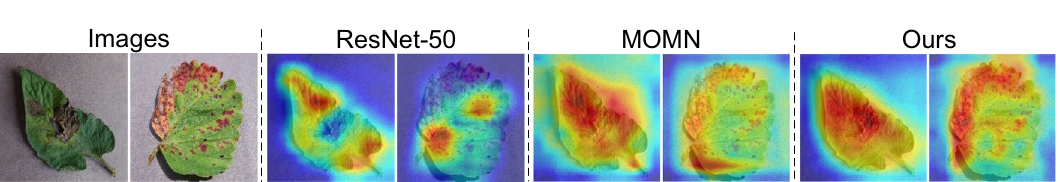
ResNet-50 MOMNImages Ours